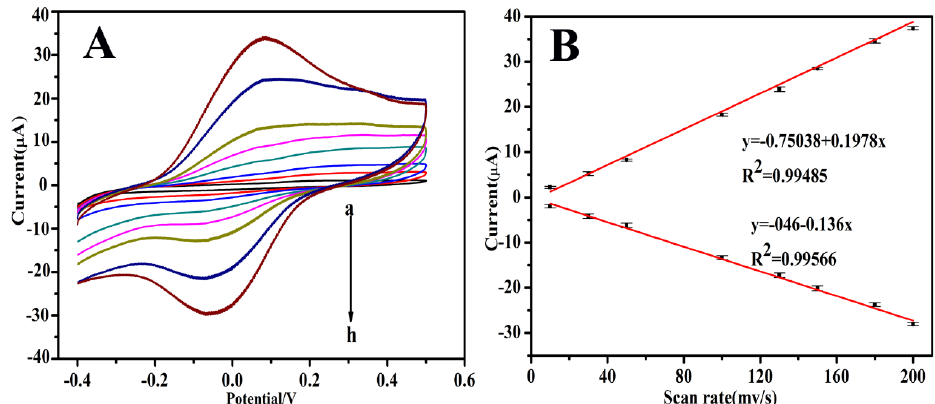
Figure 3. ( A ) CV of the immunosensor at different scan rates (from a–h): 10, 30, 50, 100, 130, 150, 180, and 200 mV s − 1 in PBS solution (pH 7.4). ( B ) The linear relationship between the peak currents and the scan rate.